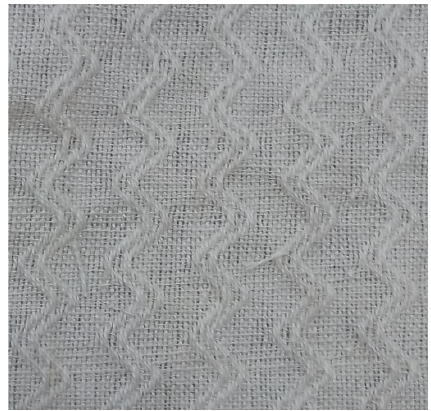
Figure 6. Auxetic woven fabric sample.